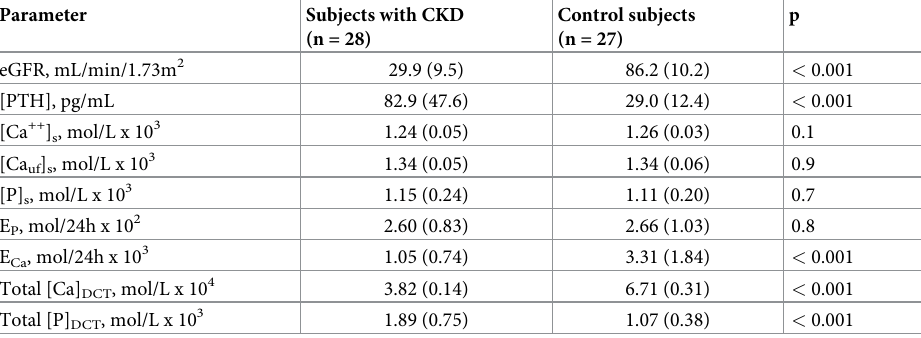
Table 2. Parameters unaffected by pH or precipitation of Ca 3 (PO 4 ) 2 (am., s.) in the DCT a .